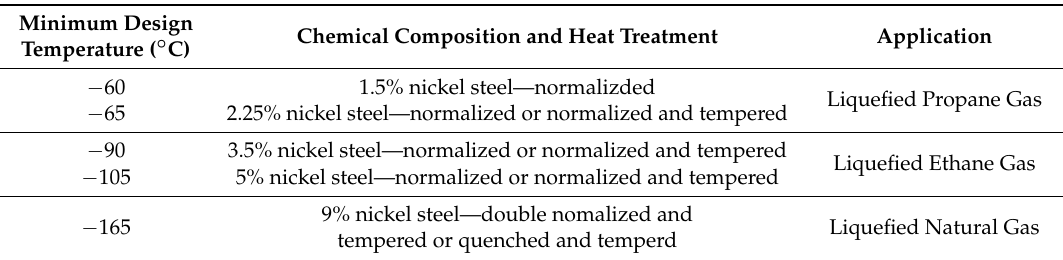
Table 1. Various temperature application of nickel steels [8].